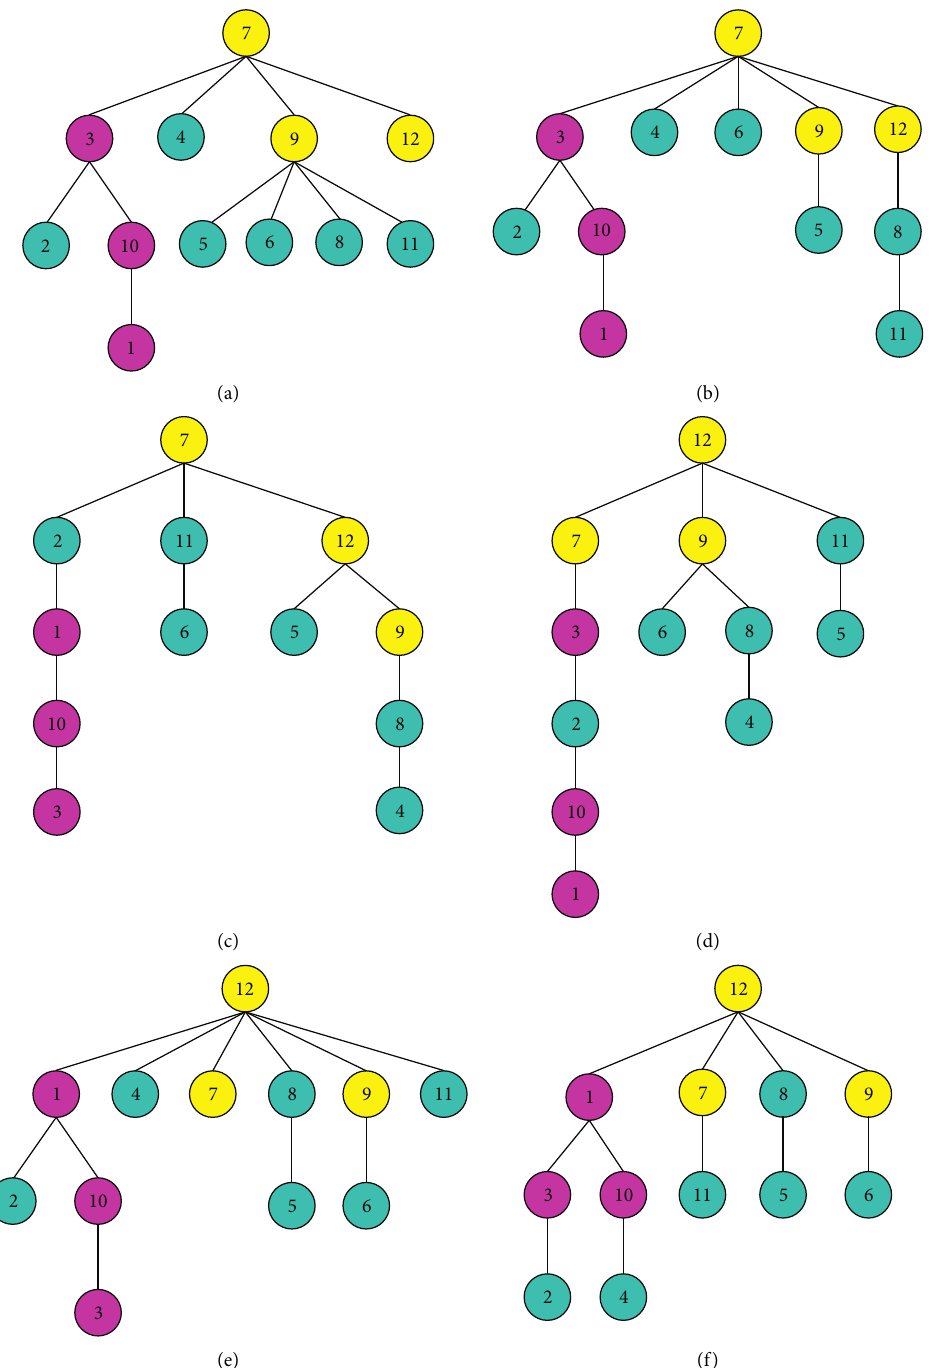
Figure 3: Maximum spanning trees (MSTs) of the 12 provinces. (a) 2015. (b) 2016. (c) 2017. (d) 2018. (e) 2019. (f)